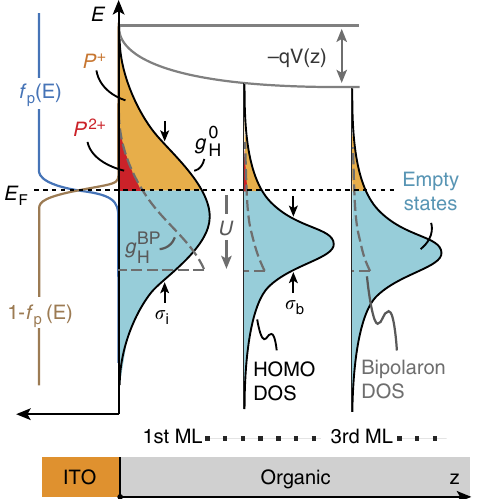
Fig. 4 Bipolaron interface energetic model. Diagram of the interfacial energy level alignment model. A Gaussian HOMO density of states ( g 0 ) is H assumed for each monolayer of the organic, with different broadening assumed for the interface ( σ i in the fi rst monolayer) and the bulk ( σ b in subsequent monolayers). States above the Fermi level that are occupied by holes ( P + , orange shading) subsequently become possible sites for bipolaron formation at lower energy, leading to the gray-dashed bipolaron DOS shifted down by U . The states in g BP that lie above E F become H bipolarons ( P 2+ , red